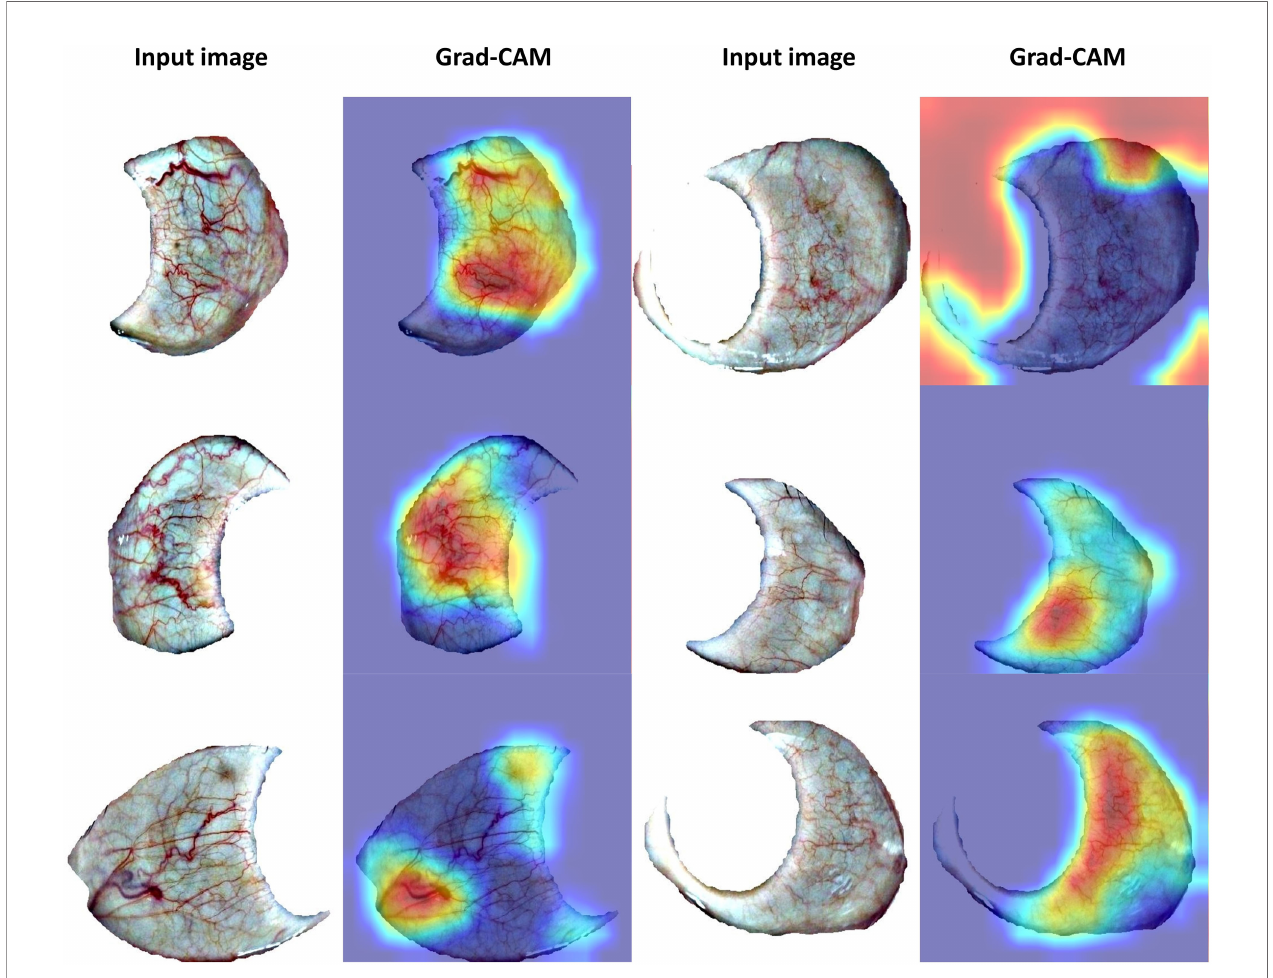
FIGURE 5 | Visualization results with